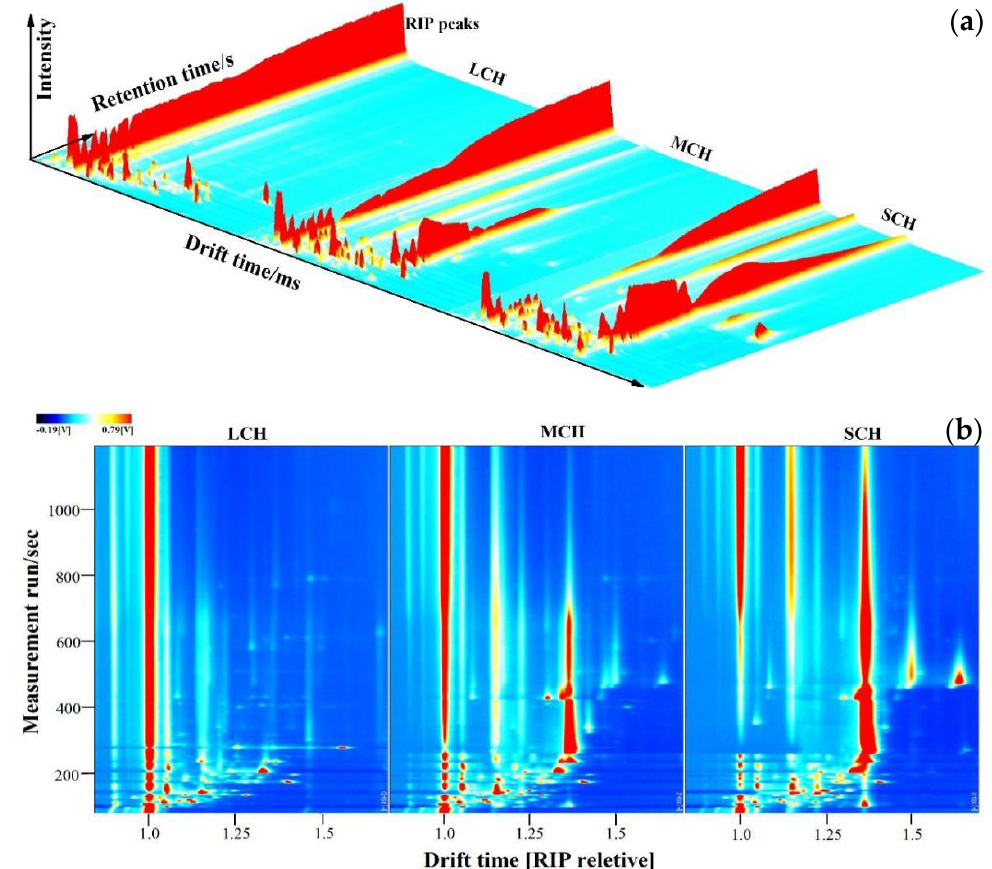
Figure 1. 3D-chromatograms ( a ) and two dimensional ( b ) GC-IMS spectra of volatile profiles in coconut haustorium. (The background of two-dimensional ( b ) was blue, and the red vertical line at abscissa 1.0 was RIP peaks (reaction ion peak, normalized). The ordinate represents the retention time (s) of GC, and the abscissa represents the ion drift time (normalization). Each point on both sides of RIP represents a volatile compound.).